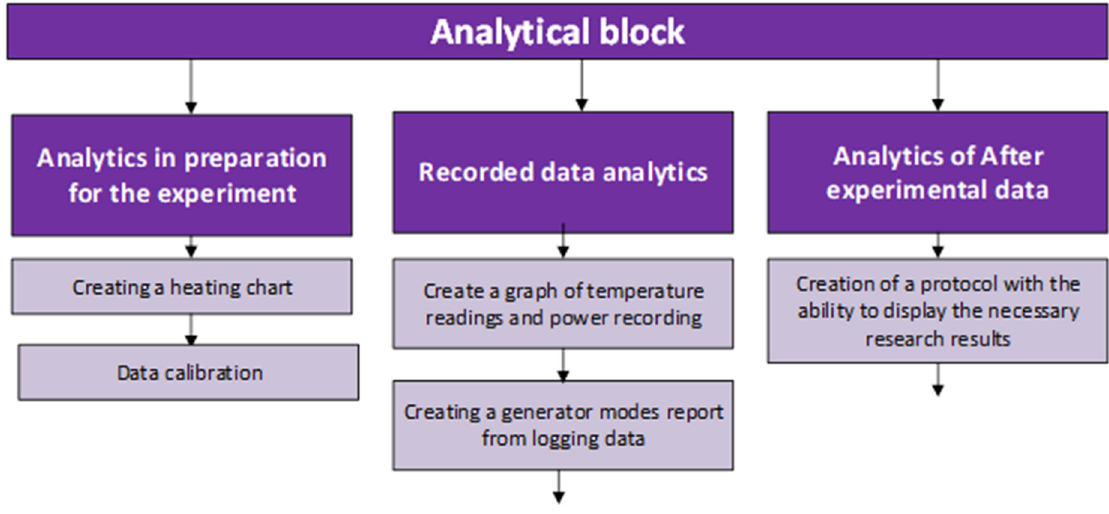
Figure 3. Analytical block of IAS.